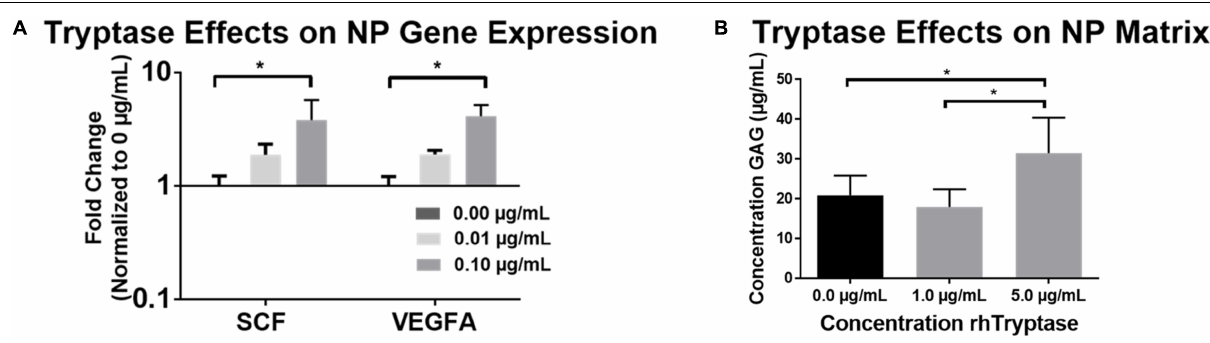
FIGURE 3 | (A) Average fold changes in qRT-PCR gene expression in human NP cells ( N = 4) in 3D agarose constructs treated with rhTryptase and normalized to untreated controls ( ∗ p < 0.05). (B) GAG release into media from freeze-thawed human NP explants from cadaveric (autopsy) IVD specimens ( N = 8; ∗ p <